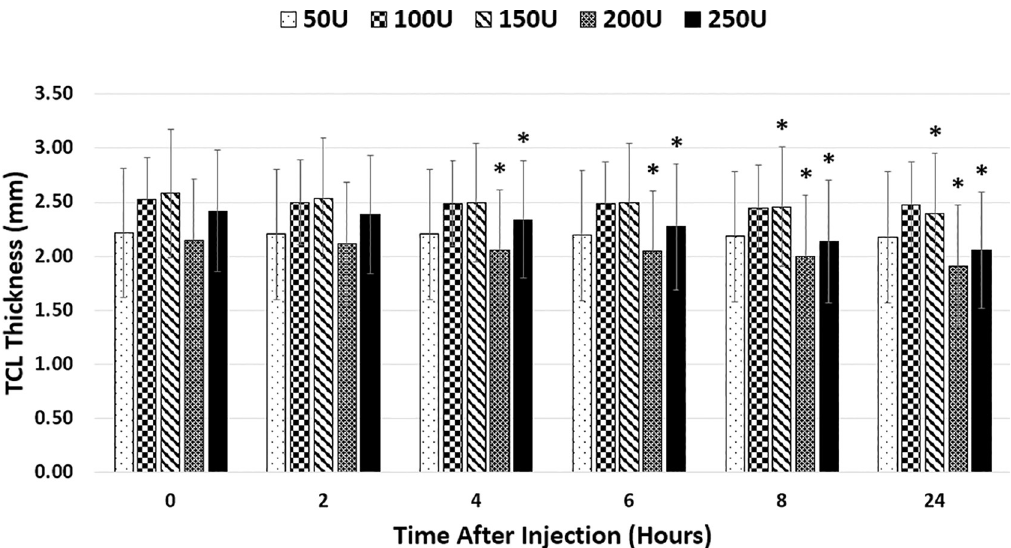
Fig 6. Thickness results. TCL thickness of individual doses at different timepoints. Significant change in thickness from time 0 within dose signified by ( � ).